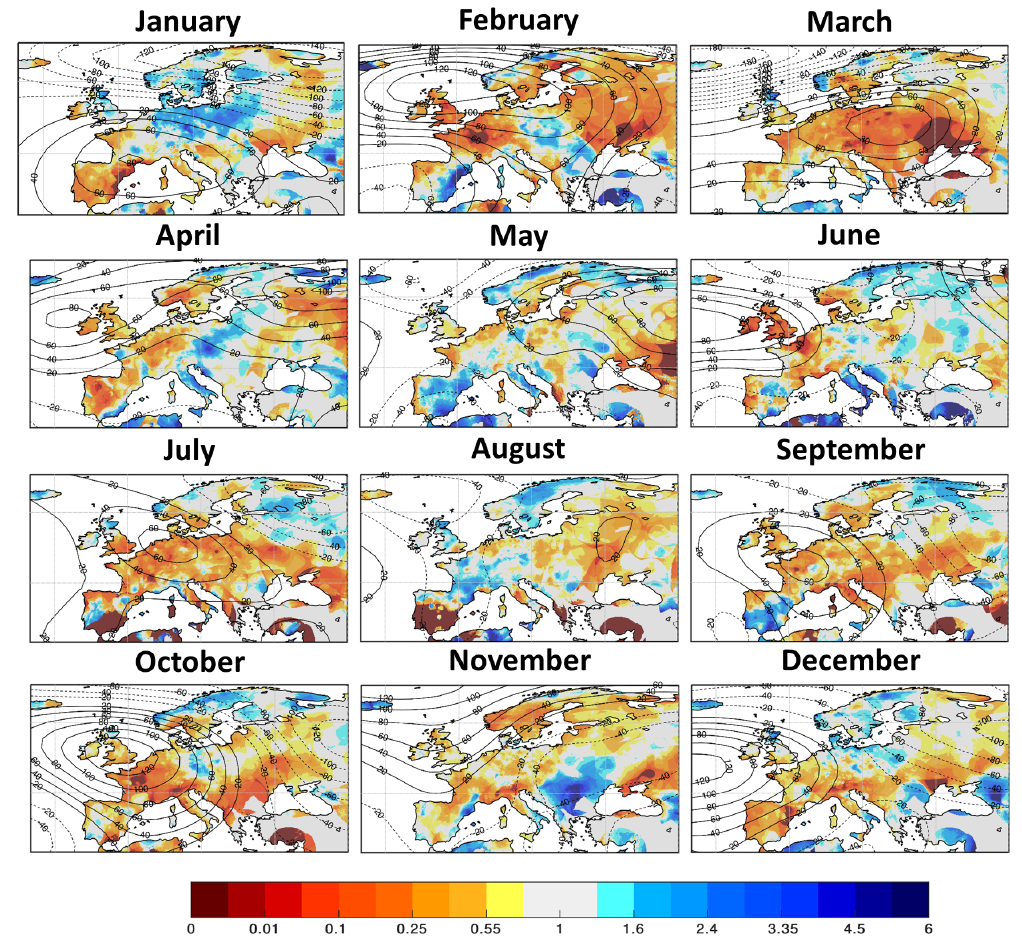
Figure 11. Monthly precipitation totals for January to December 1921 as the ratio of the corresponding 1981–2010 climatology. Contours show the Z500 anomalies (solid lines for positive, and dashed lines for negative, in 20m